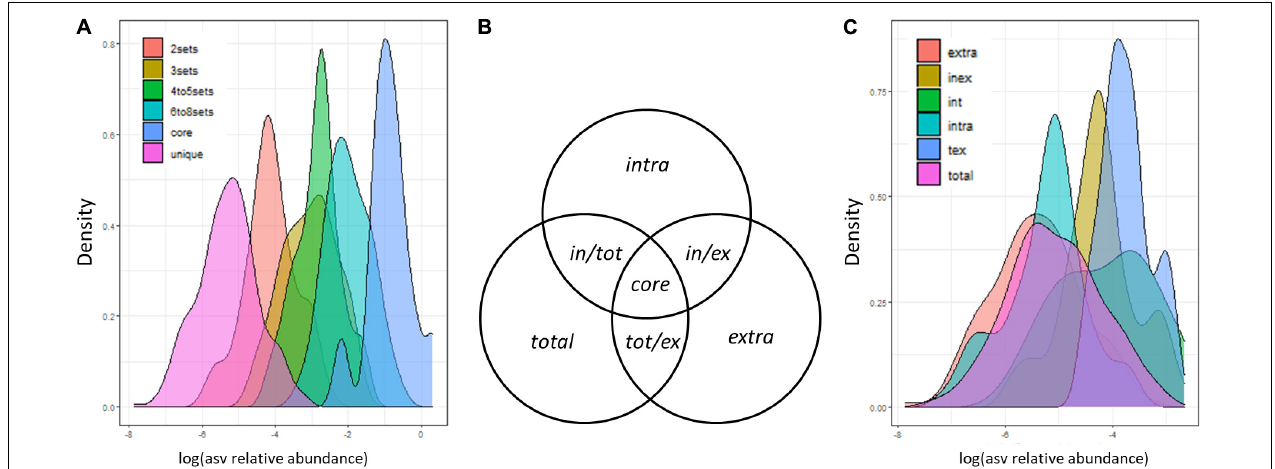
FIGURE 3 | Distribution of ASV sizes (sequence proportions). ASVs were categorized based on (A) the number of sample groups (3 decay classes × 3 DNA types) and (C) the sets of DNA types (extracellular and intracellular DNA fraction, total DNA pool), in which they were detected. (B) Set definitions of DNA fractions, in which ASVs can be detected. These definitions are applied in panel (C) and in the